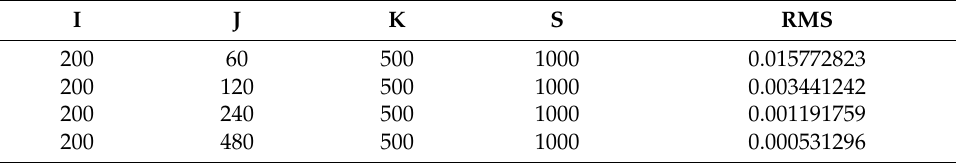
Table 2. Convergence for different mesh sizes along the oY axis.